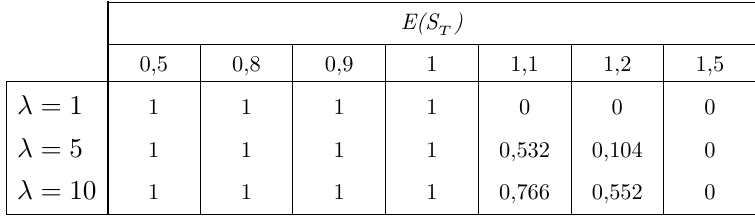
Optimal hedge ratio h * for different expected prices and risk aversion coefficients E(S ) T 0,5 0,8 0,9 1 1,1 1,2